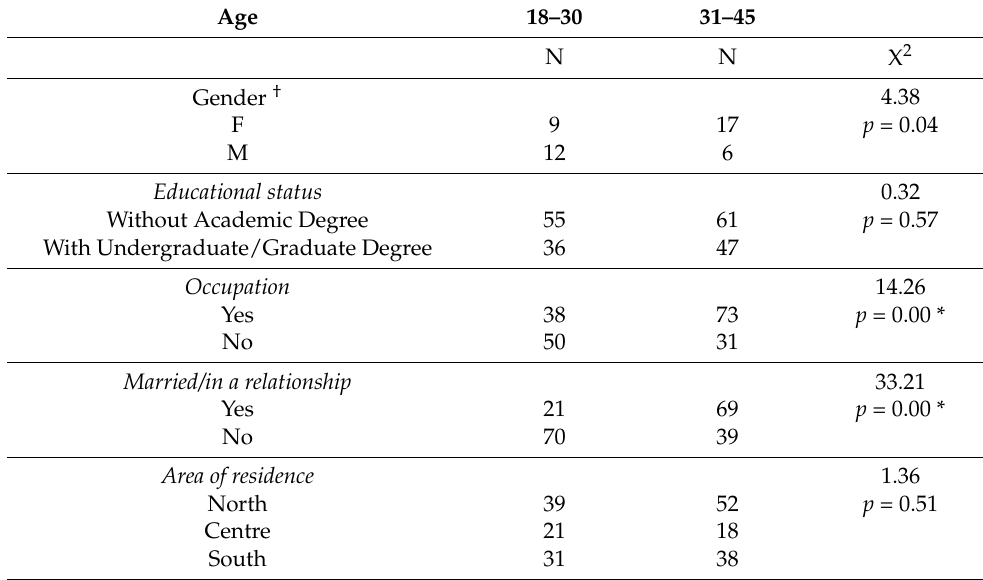
Table A1. Socio-demographic and clinical characteristics of respondents by age groups (N =